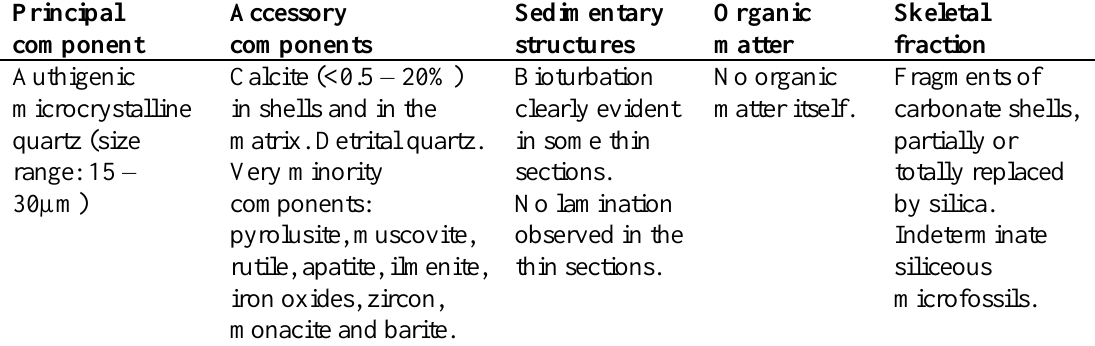
Table 2. Microscopic traits seen in the thin sections of Mucientes chert. Principal